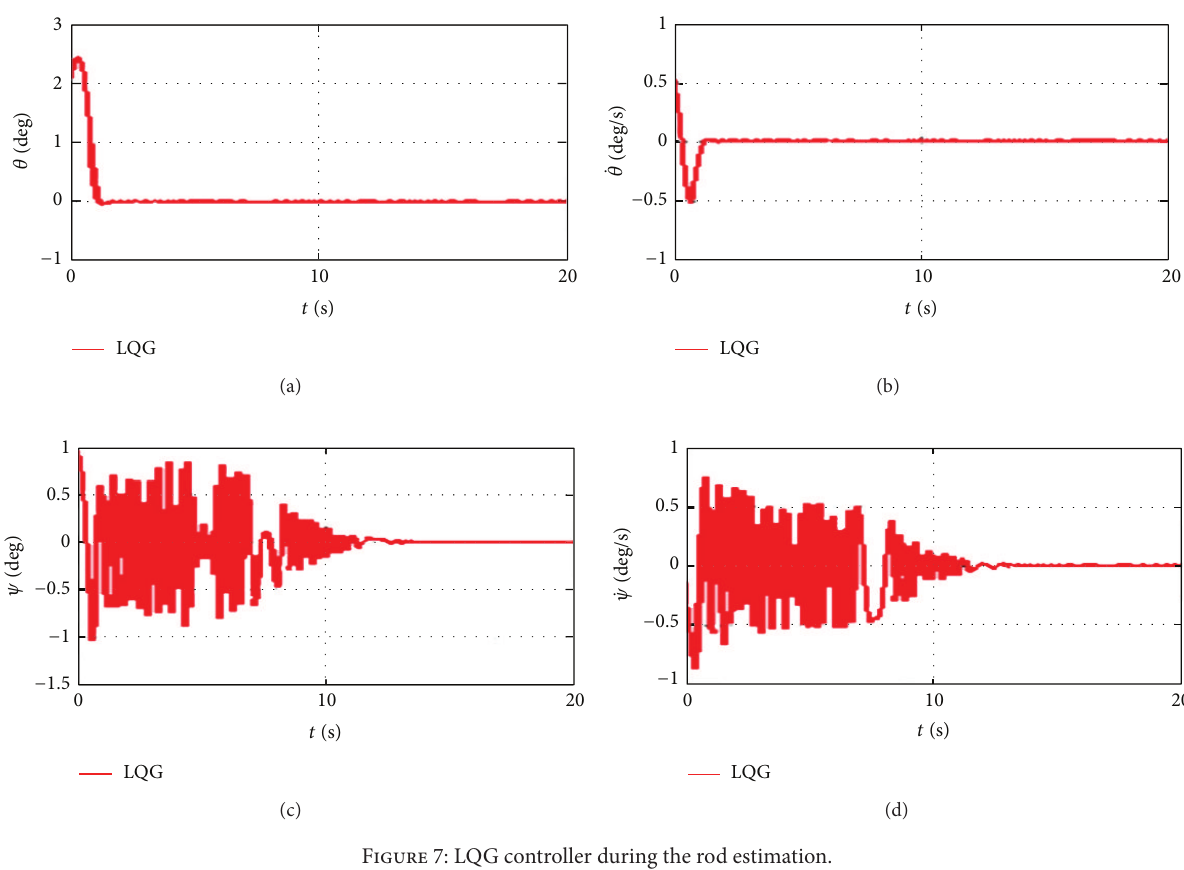
Figure 7: LQG controller during the rod